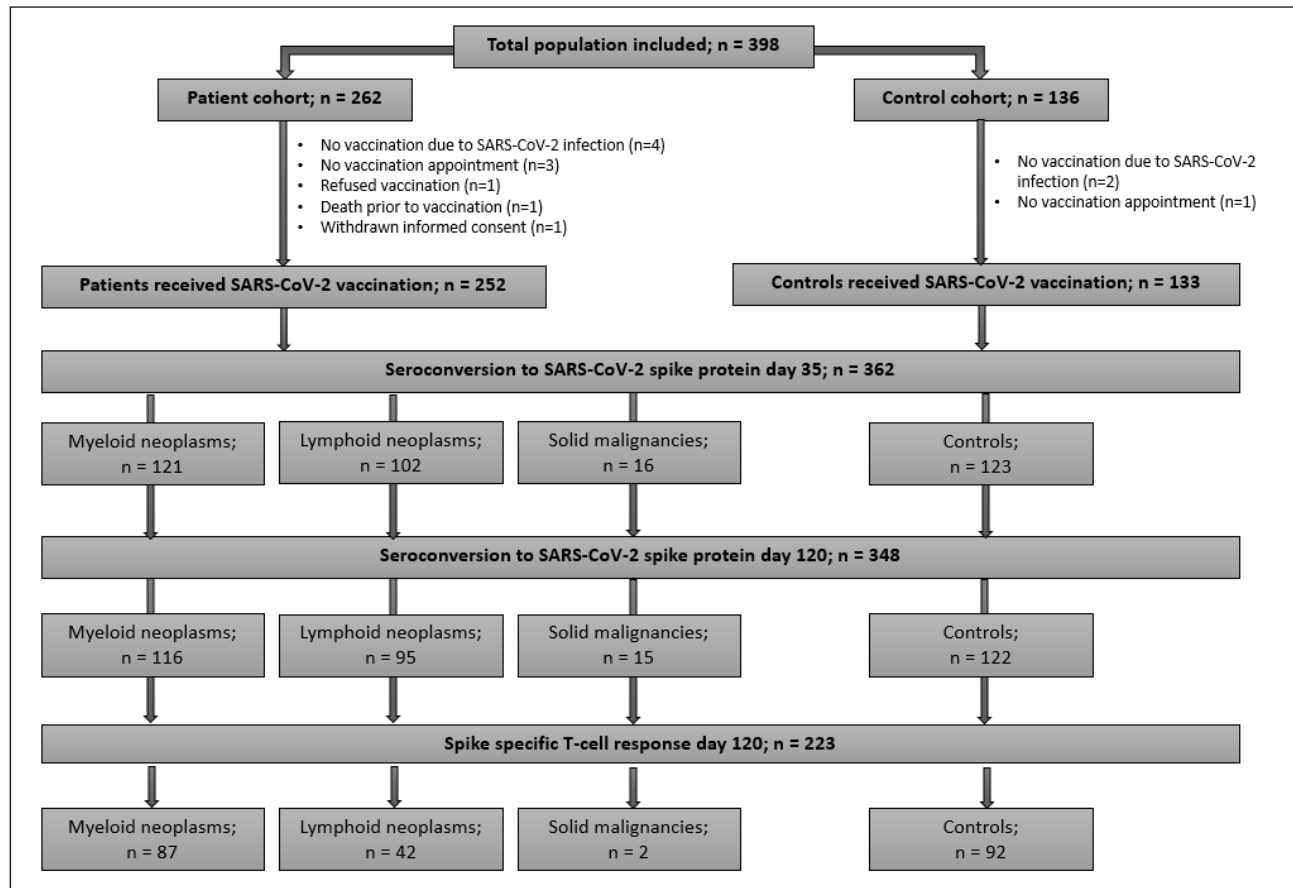
Figure 1. CONSORT flowchart of study population. Table 2. Baseline characteristics of vaccinated study population.